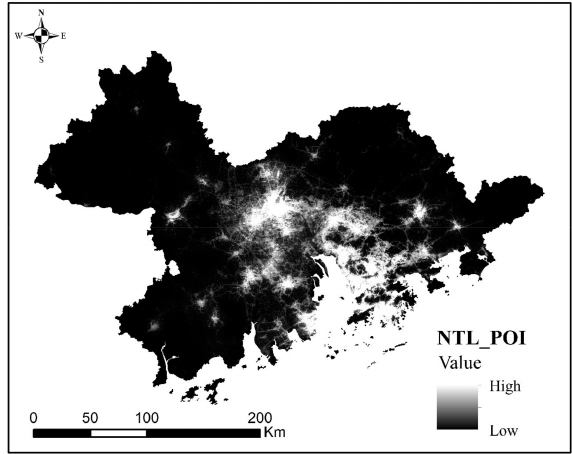
Figure 9. Image after fusion of NTL and POI data by wavelet transform. The parameters of Scale, Shape and Compactness determined by the ESP tool and the weighted mean variance diagram (Figure 8b) are 17, 0.5, and 0.7, respectively. According to the determined scale parameters, the urban agglomeration boundaries of the NP image are delineated. Then the boundary of the urban agglomeration in GBA is obtained as shown in Figure 10. It can be seen that the area of the urban agglomeration in the area delineated in Figure 10 is 8279.56 square kilometers, accounting for 14.78% of the administrative area. The delineated urban agglomeration regions mainly concentrate in the main urban areas of Guangzhou, Shenzhen, Dongguan and Foshan, as well as Hong Kong and Macao. From the point of view of the urban agglomeration boundaries delineated here, the urban agglomeration boundaries of Guangzhou, Foshan, Dongguan and Shenzhen are